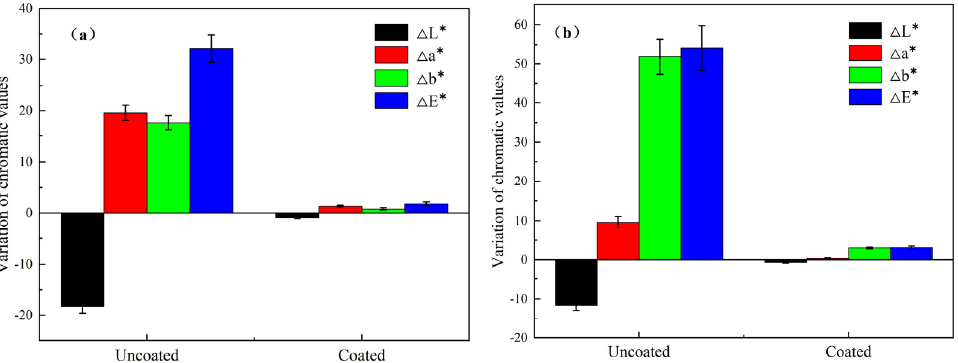
Figure 11. Variation in chromatic values of the coated and uncoated walls. ( a ) Building walls contaminated with particulate pollutants. ( b ) Building walls contaminated with liquid pollutants.